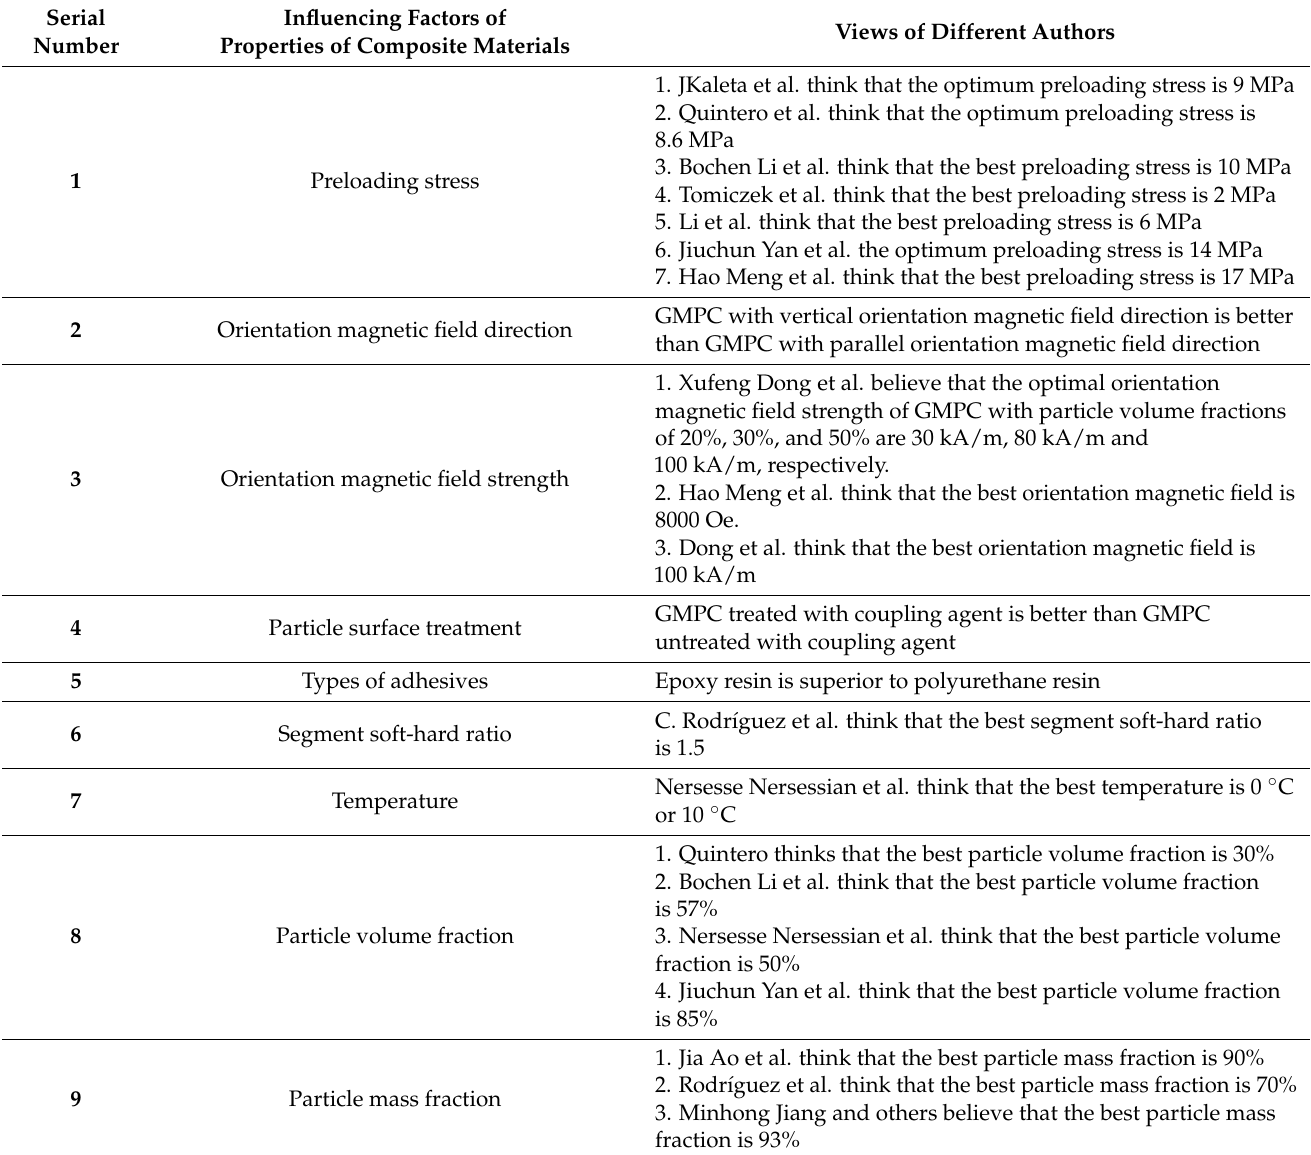
Table 3. Research Summary of Magnetostrictive